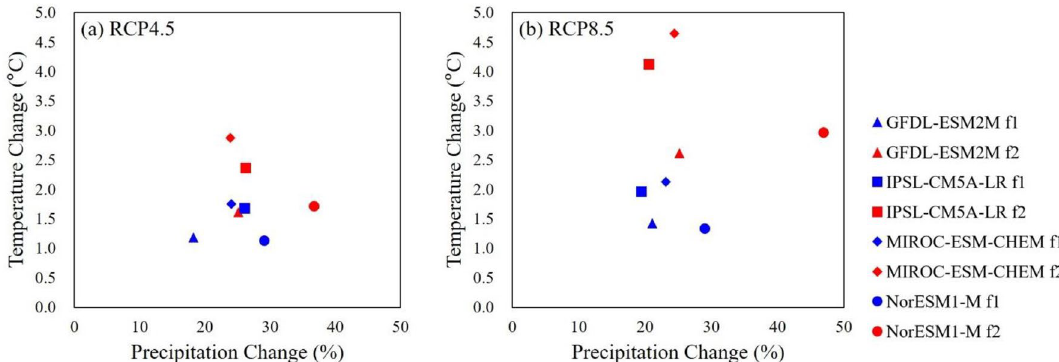
Figure 3. Precipitation and temperature change in the LMB. The X-axis is the change in precipitation (%), and the Y-axis is the change in temperature (°C). All of the dots indicate the change in precipitation and temperature for each climate model and period. The blue dots represent the f1 period, and the red dots indicate the f2 period. ( a ) RCP 4.5. ( b ) RCP